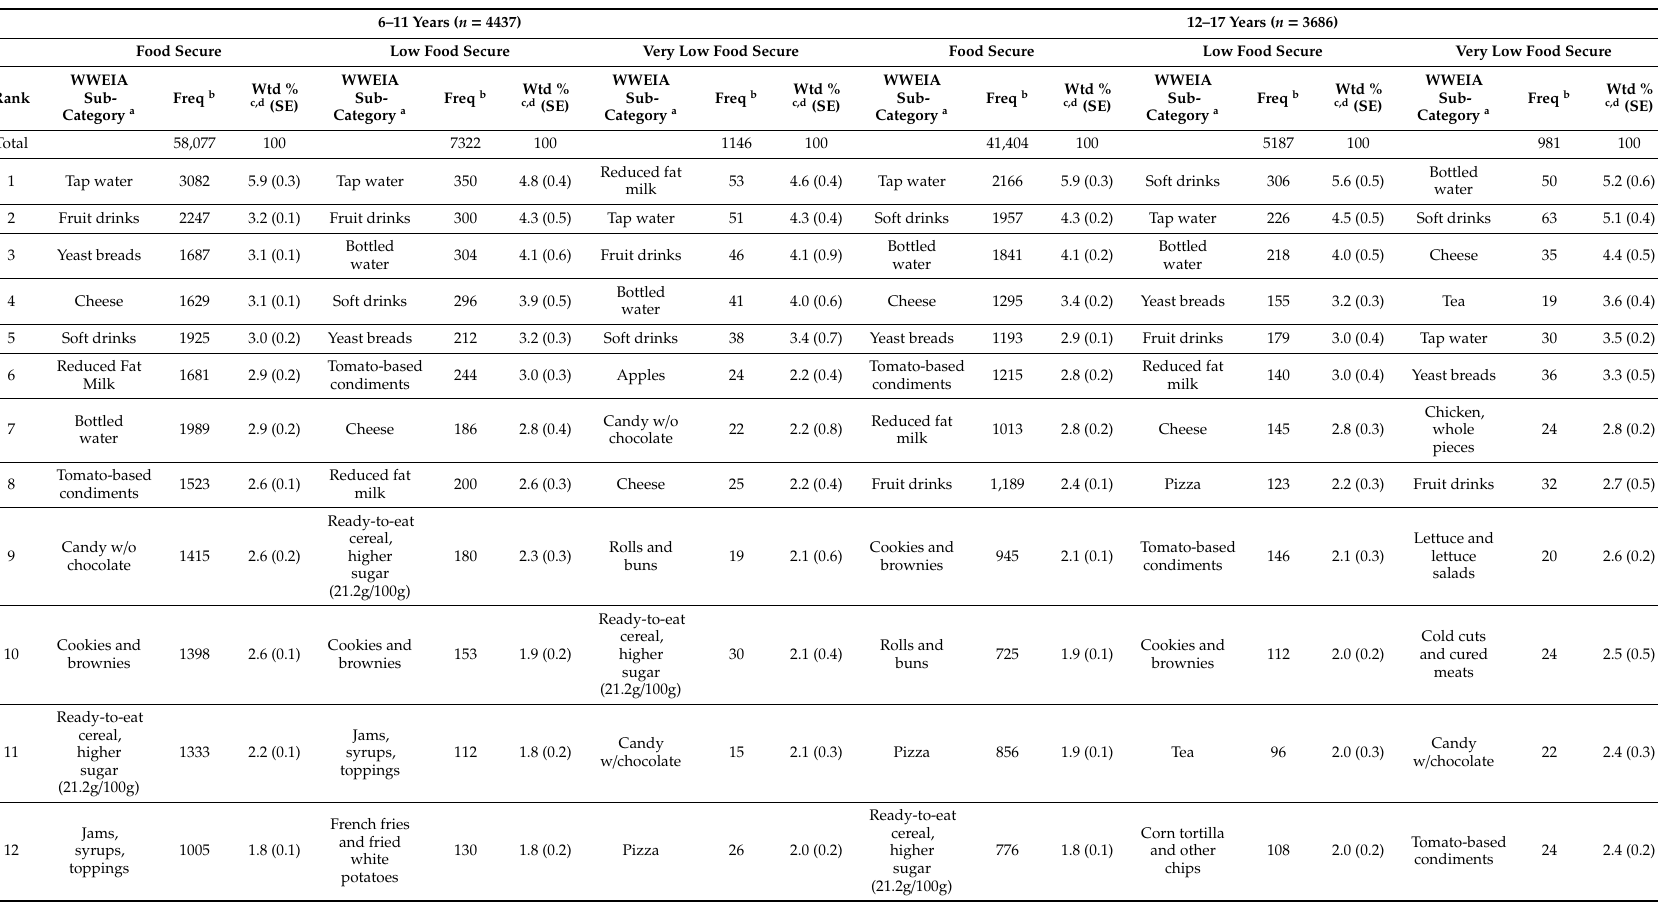
Table 3. Top 25 most frequently consumed What We Eat in America food or beverage sub-categories a , unweighted frequency of reported intake from food or beverage sub-categories, weighted percent and standard error of weighted percent of reported food or beverage sub-categories among all reported sub-categories for food secure, low, and very low food secure U.S. children and adolescents aged 6–11 and 12–17 years using the National Health and Nutrition Examination Survey